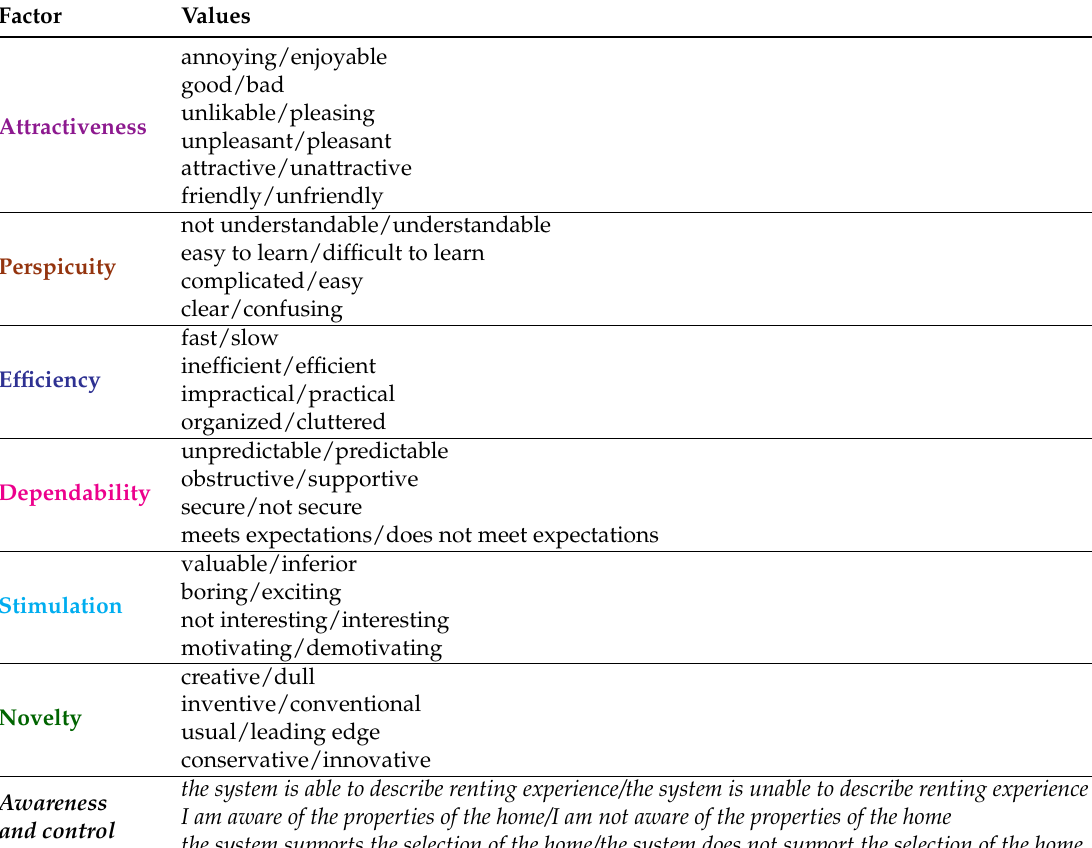
Table 3. Post-test questionnaire: UX aspects grouped by factor. We consider the 6 UEQ factors plus an extra one (in italics) that describes user awareness and control. The last three items are translated from the Italian language.